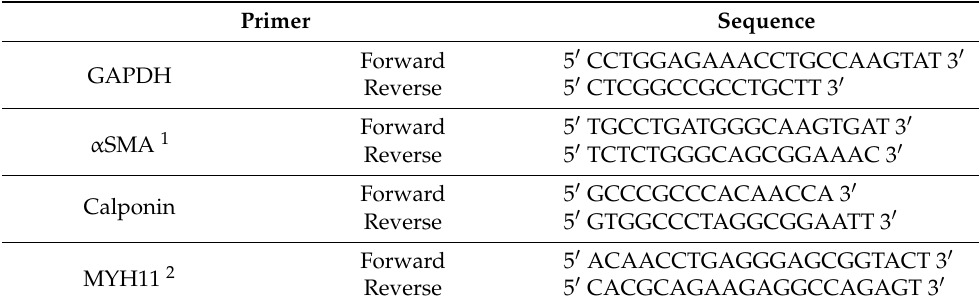
Table 1. Summary of the primary sequence used for the RT-PCR